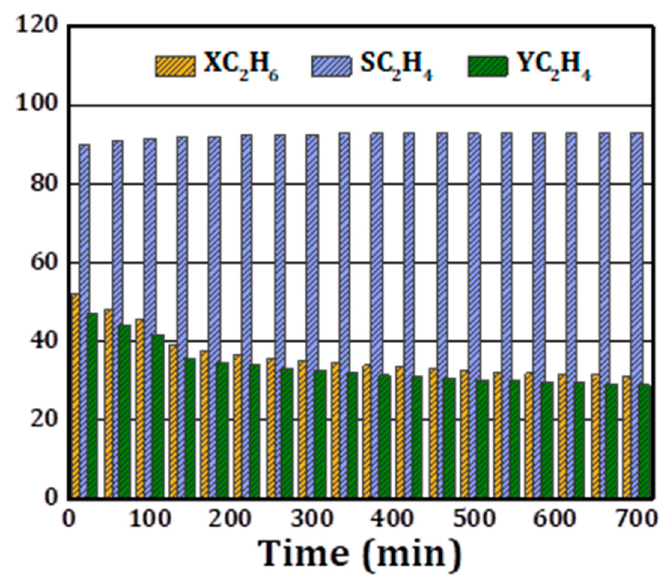
Figure 10. Variation of C 2 H 6 conversion C 2 H 4 yield and selectivity with time-on-stream over the Cr(4)/LPMS-130 catalyst.